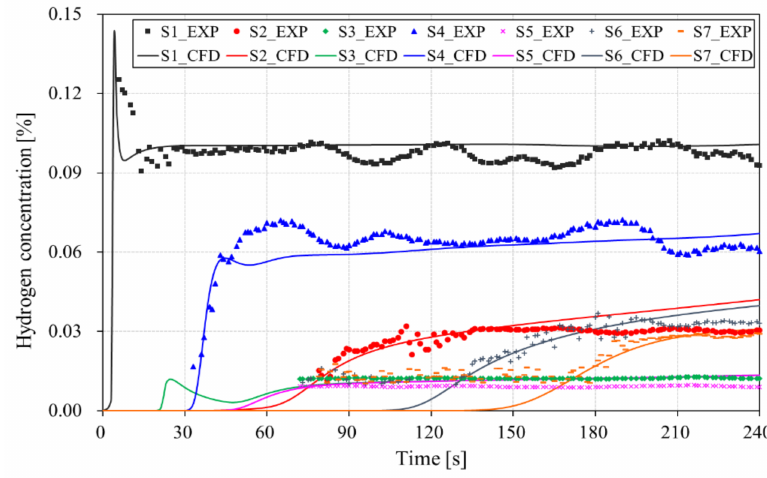
Figure 5. Comparisons between predicted hydrogen concentrations by experimental and FLUENT data.